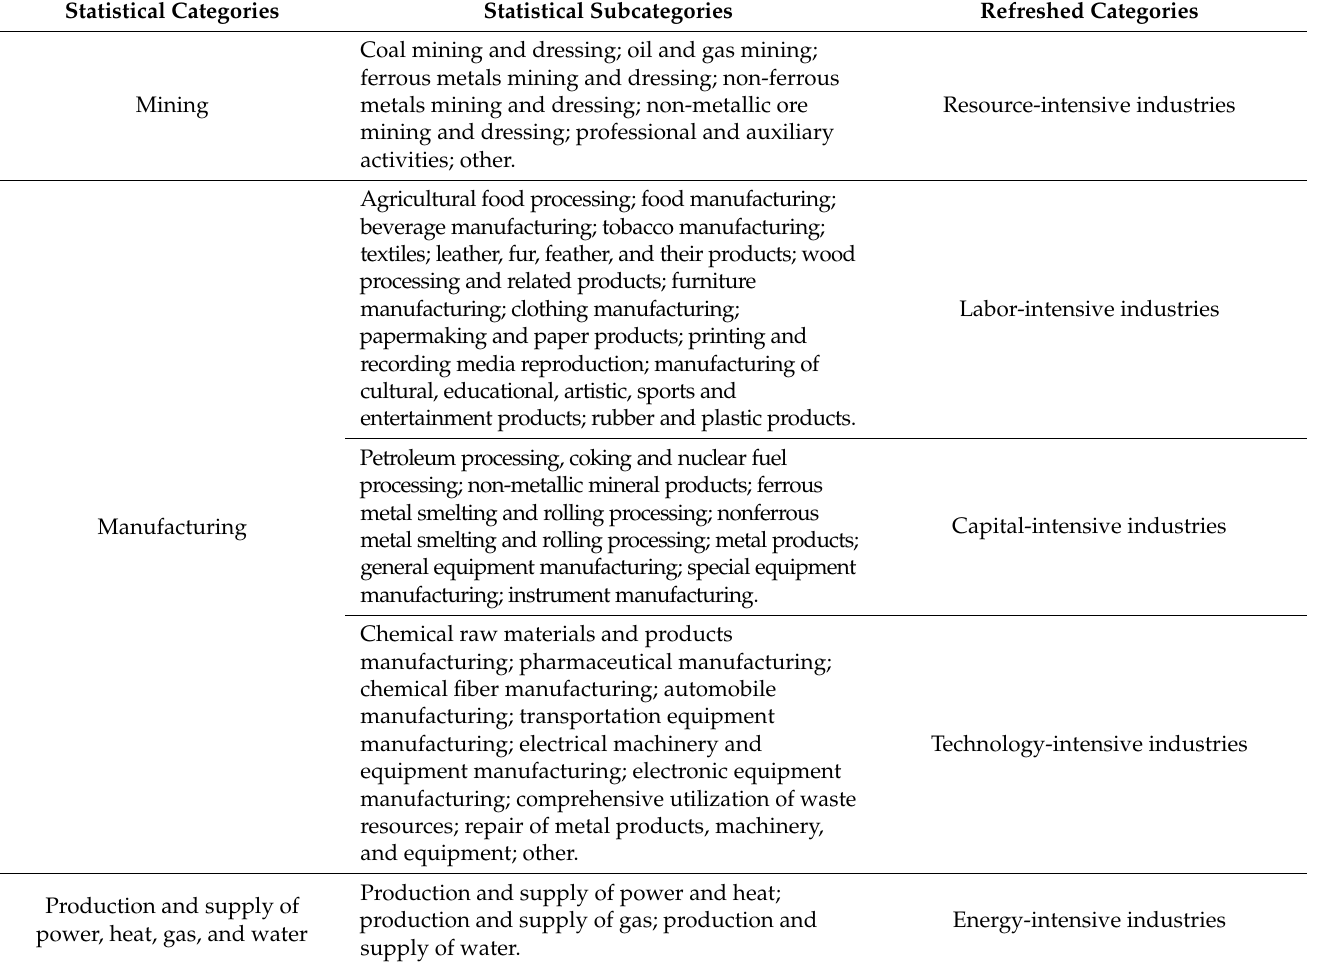
Table 1. Industry categories in statistical yearbook and refreshed categories used by this